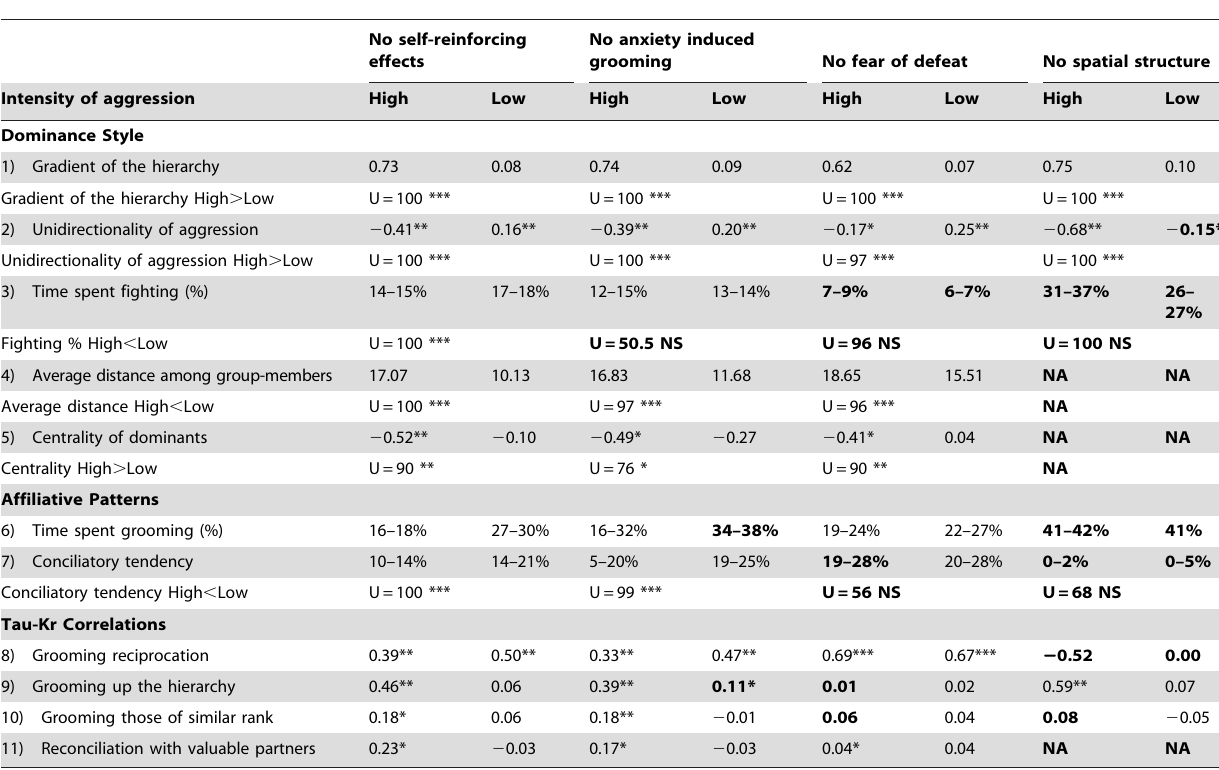
Table 5. Dominance style and affiliative patterns when taking out different assumptions (see